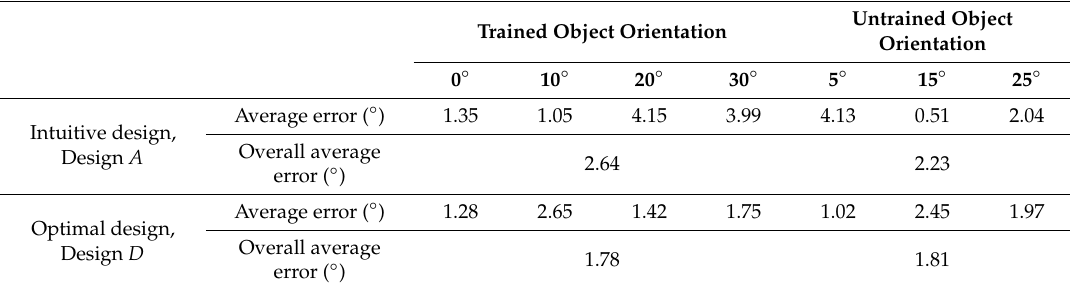
Table 3. Object orientation estimation results of each design. Trained Object